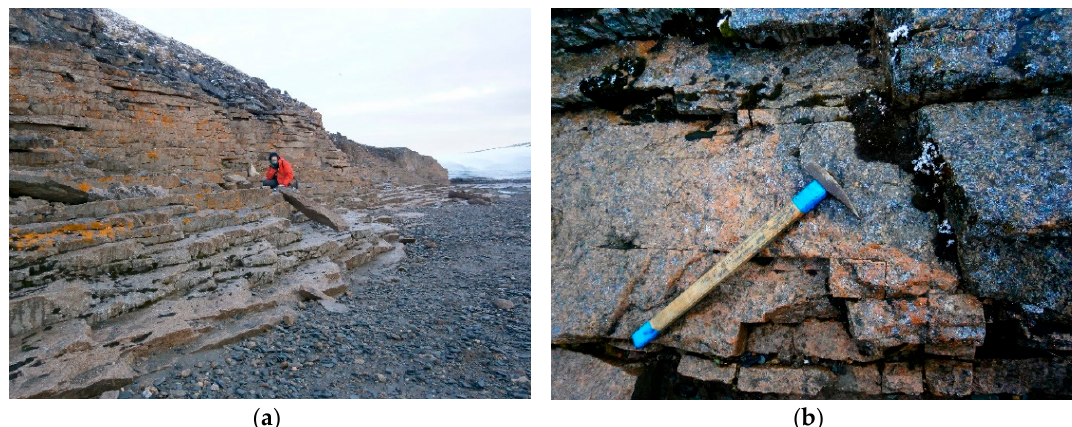
Figure 4. Field photographs of ( a ) horizontal weakly-wavy jointing of the postcollisional porphyraceous coarse-grained biotite granites (Oleniy Creek, Zeeberg Bay); ( b ) contact of pink biotite-bearing medium- to coarse-grained granite-porphyry and greenish-dark-grey hornblende-biotite coarse-grained granodiorites, with apophyses of fine-grained granite-porphyry and aplites in the upper part of the photo accompanying potassium feldspar porphyroblasts in the host granodiorites. In the region of the Tessema River mouth (western part of Cape Chelyuskin, Northern Domain),